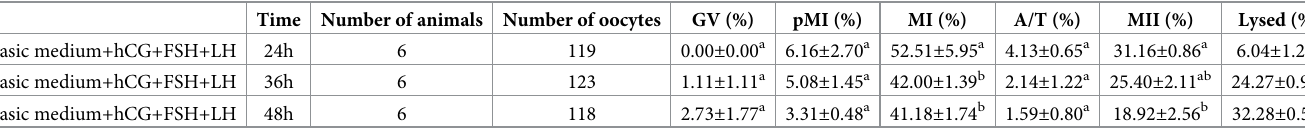
Table 4. Effects of culture duration on the IVM rate of oocytes from superovulated guinea pigs.